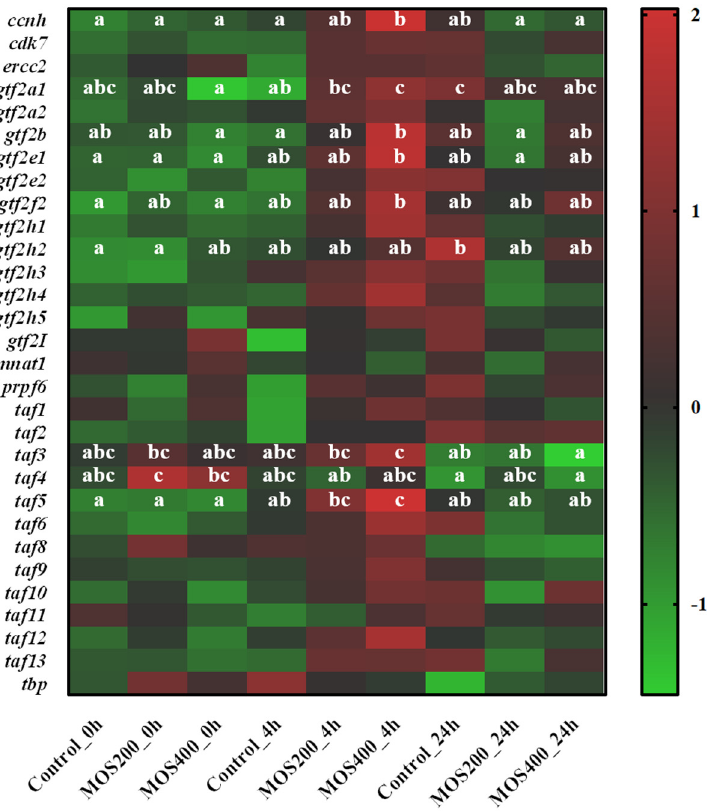
Figure 6. Heatmap of transcriptional regulation-related DEGs based on DGE profiling. The color values represented up-regulated (red) and down-regulated (green) expressions of selected DEGs, which ranged from 2 to − 1. Different alphabets indicate statistically significant differences after performing Tukey’s HSD test ( p < 0.05).